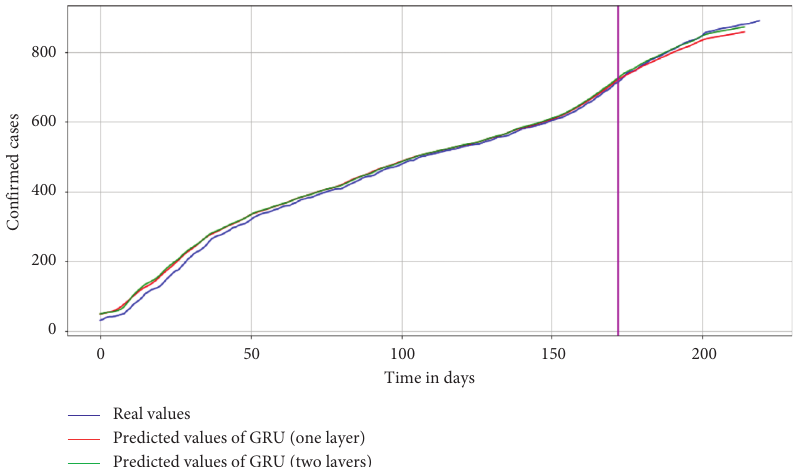
Figure 13: Comparison between real death cases and the predicted death cases for GRU